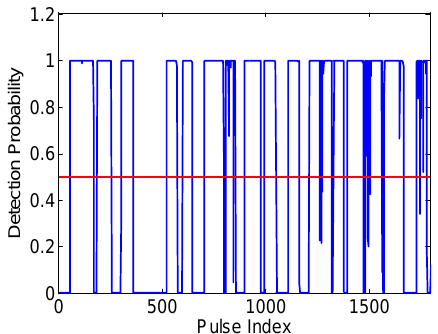
Figure 15. The detection probability of radar pulse before WBI mitigation, where the red line represents the threshold.